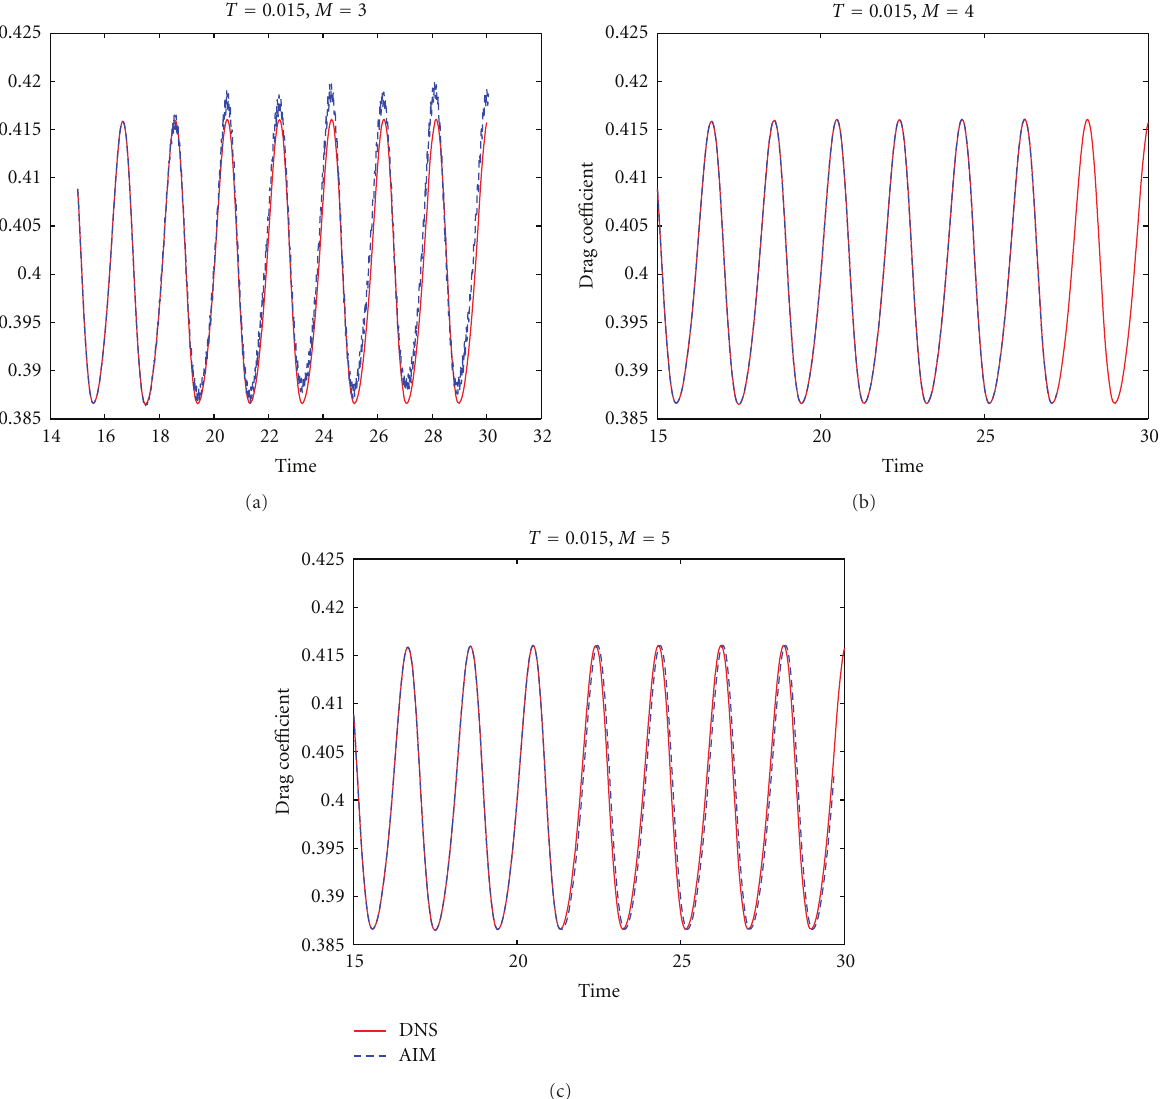
Figure 8: Periodic case: Re = 400. Computed drag coe ffi cient for T = 0 . 015 with various number of M . From top to bottom: M = 3,4, and